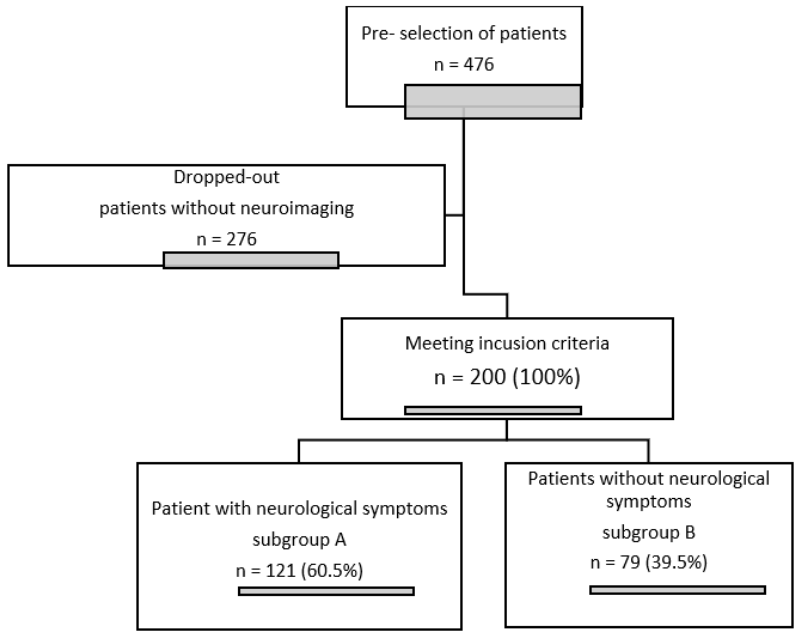
Figure 1. Flow chart of study design.